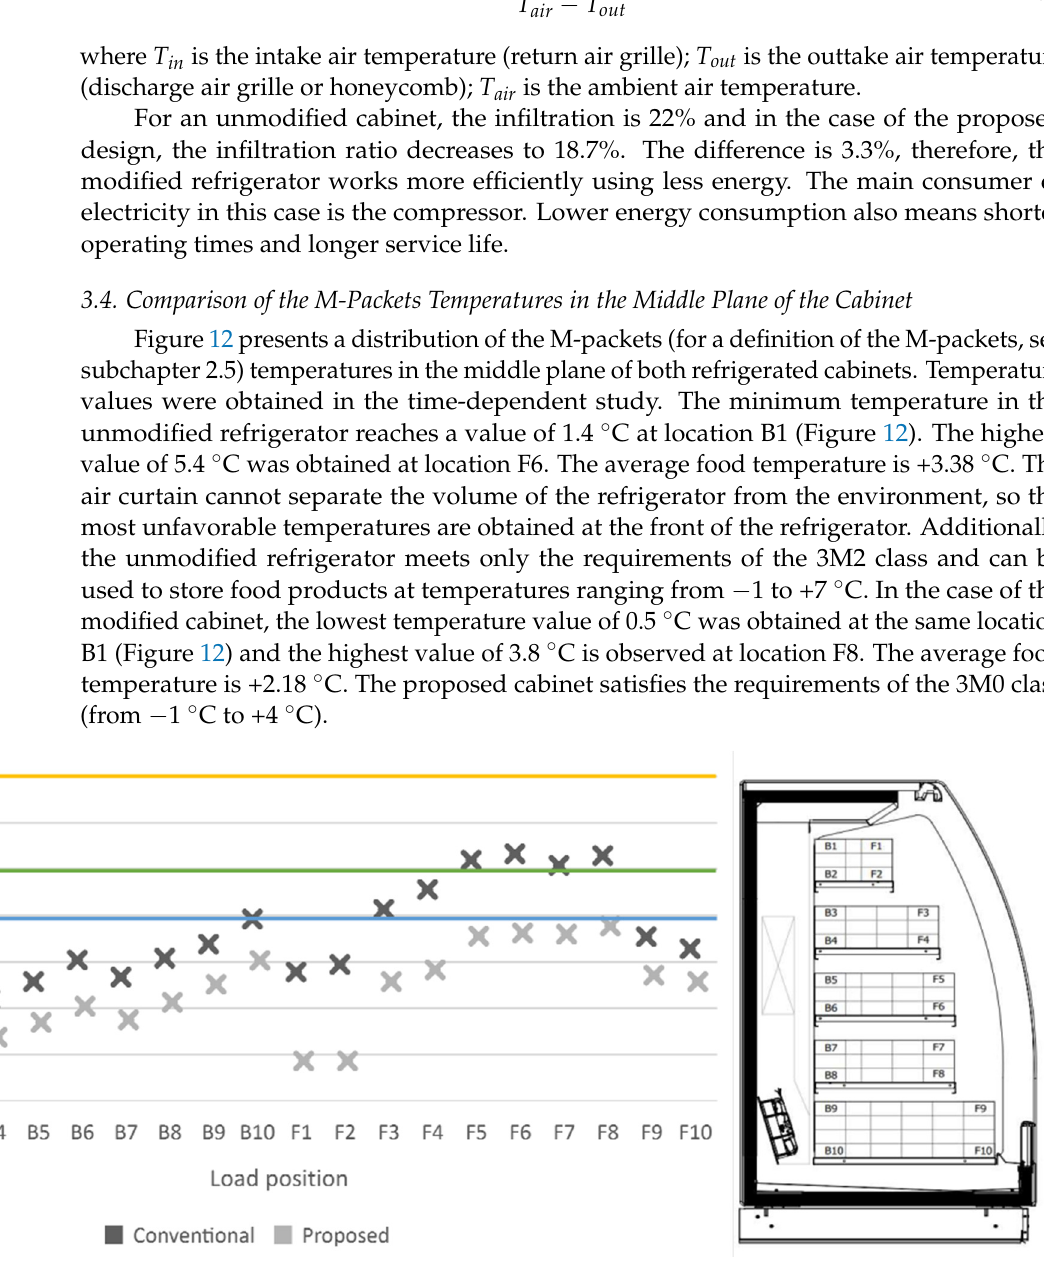
Figure 13. Distribution of the temperature of food products in the middle plane of the refrigerated cabinet (experimental data).